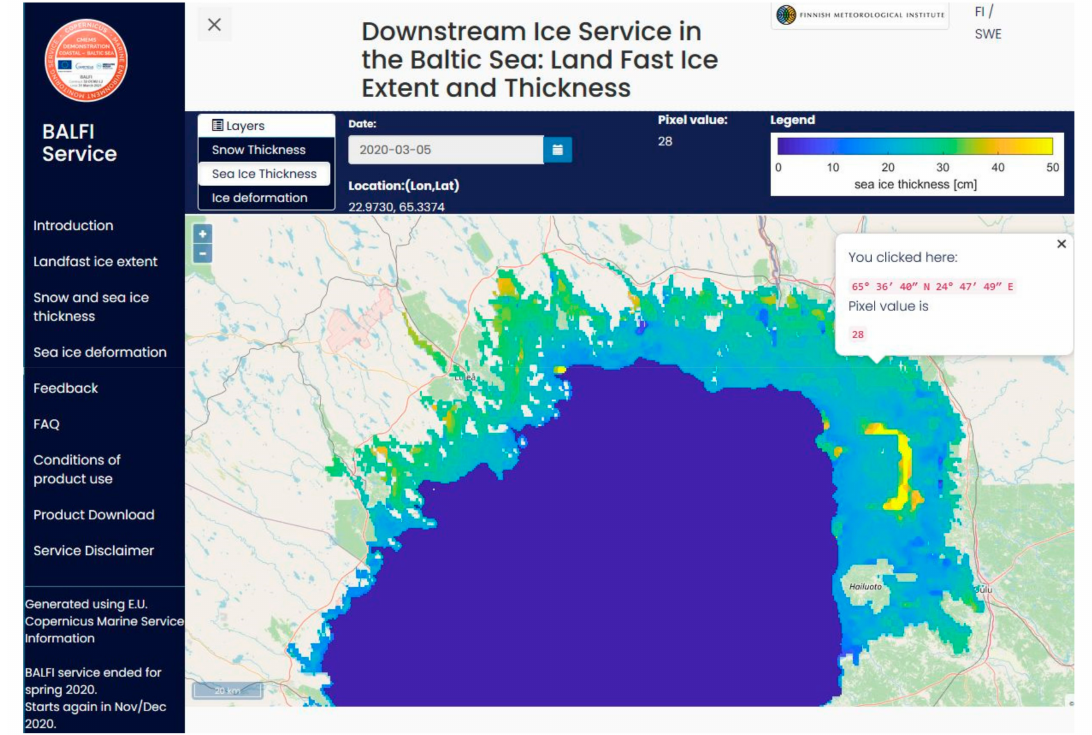
Figure 8. Screenshot of the BALFI service